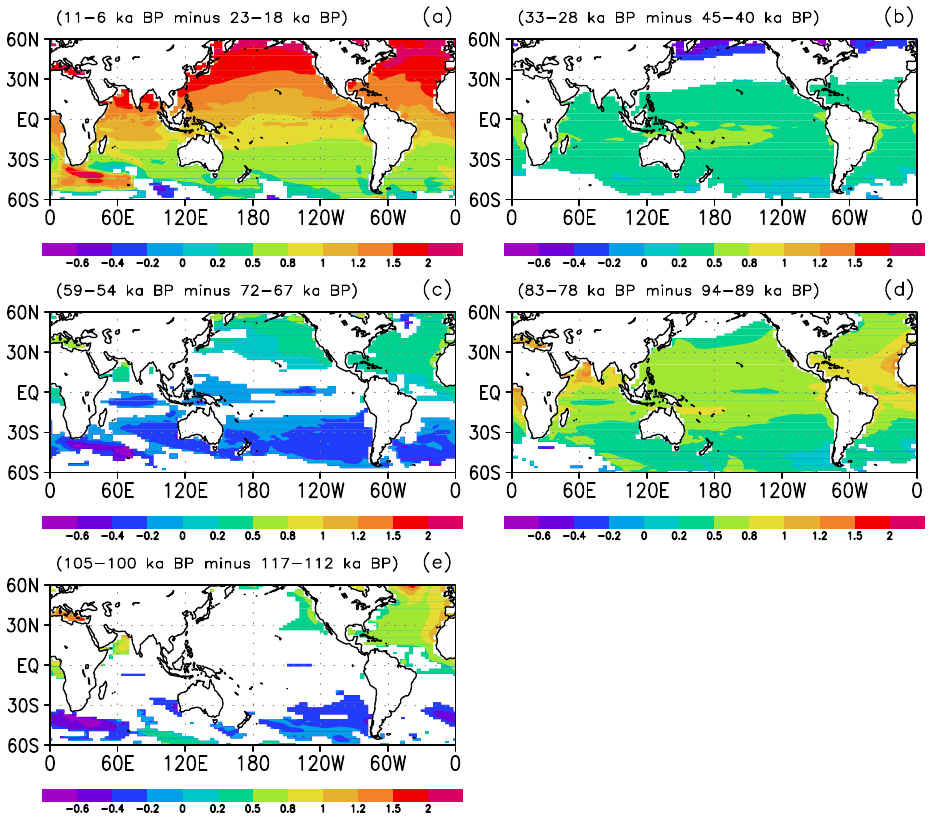
Fig. 9 . Same as in Fig. 6 but for SST. Fig. 9. Same as in Fig. 6, but for